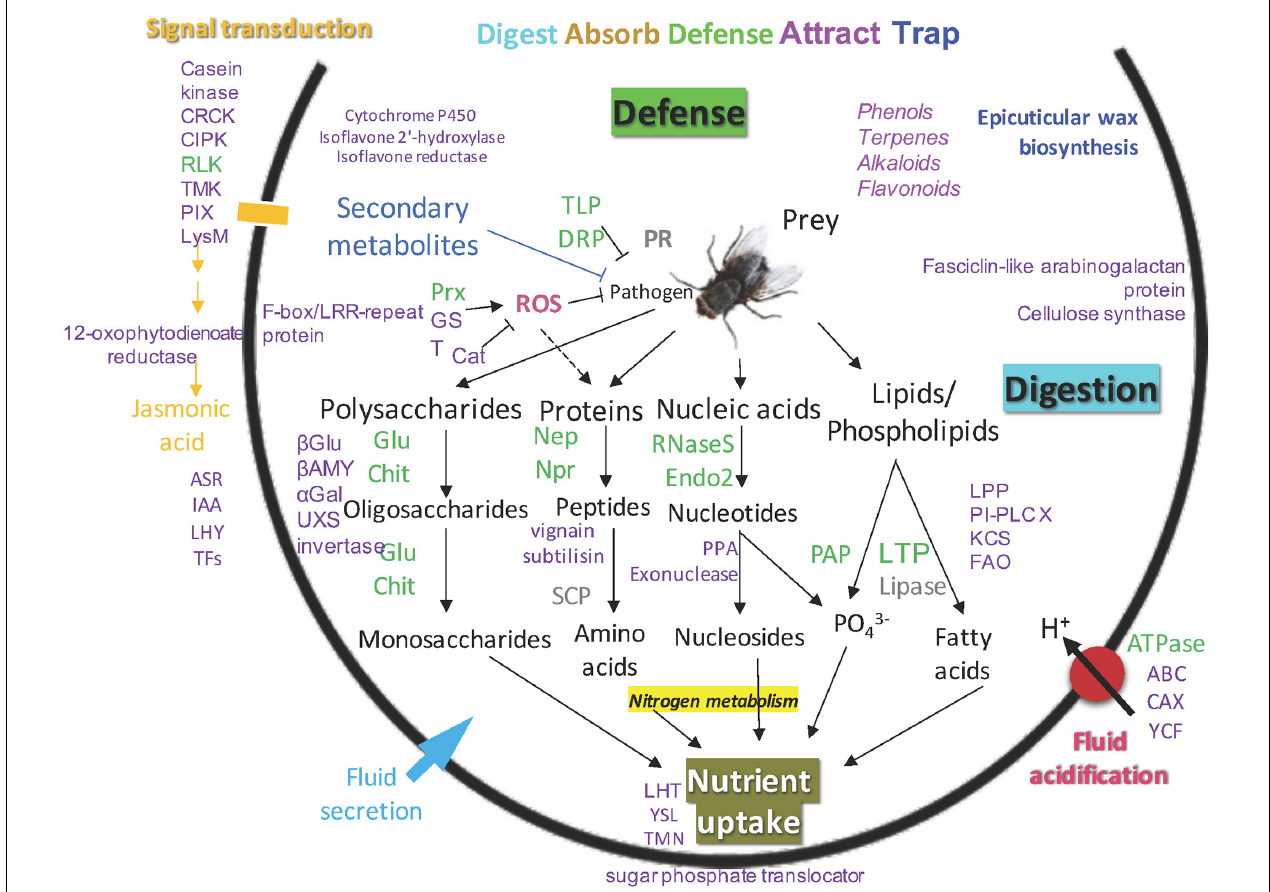
FIGURE 5 | An updated model of carnivory mechanism in Nepenthes pitchers, green: common proteins found in pitcher fluids, gray: common proteins not detected in this study, purple: new proteins found in this study, blue: new biological process identified in this